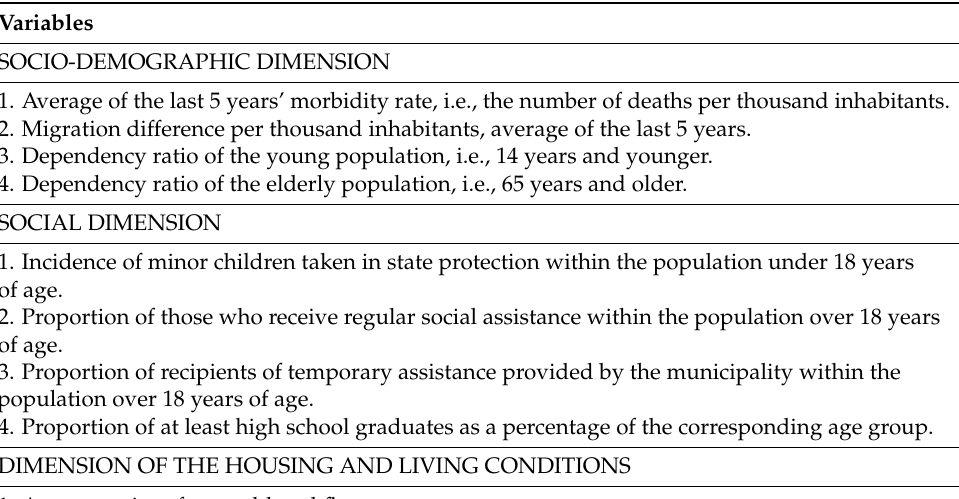
Table 4. List of the variables of settlement